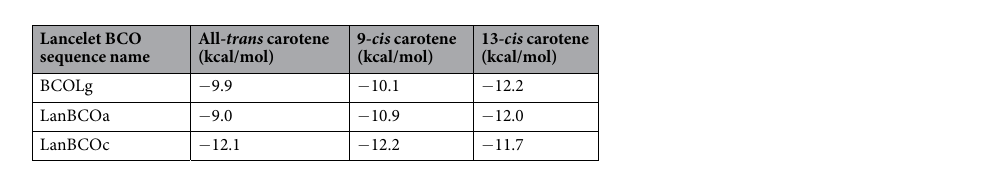
Table 3. Autodock Vina modeling of affinity of beta-carotene isomers to Lancelet BCOs. The lowest (best) docking energy is